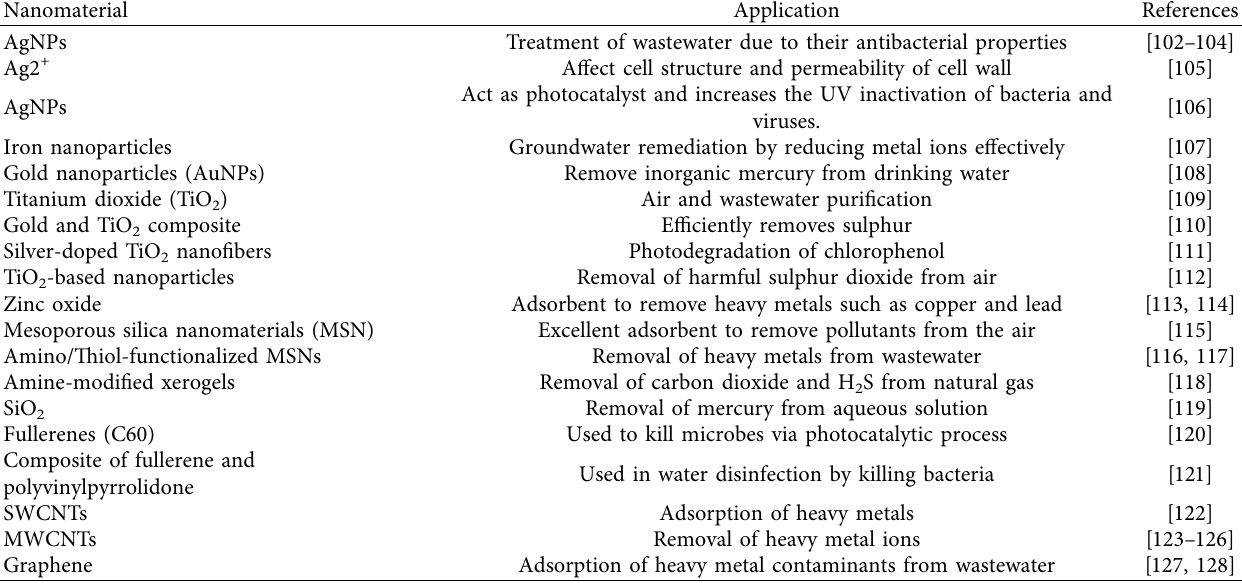
Table 2: Nanoparticles and their applications in environmental